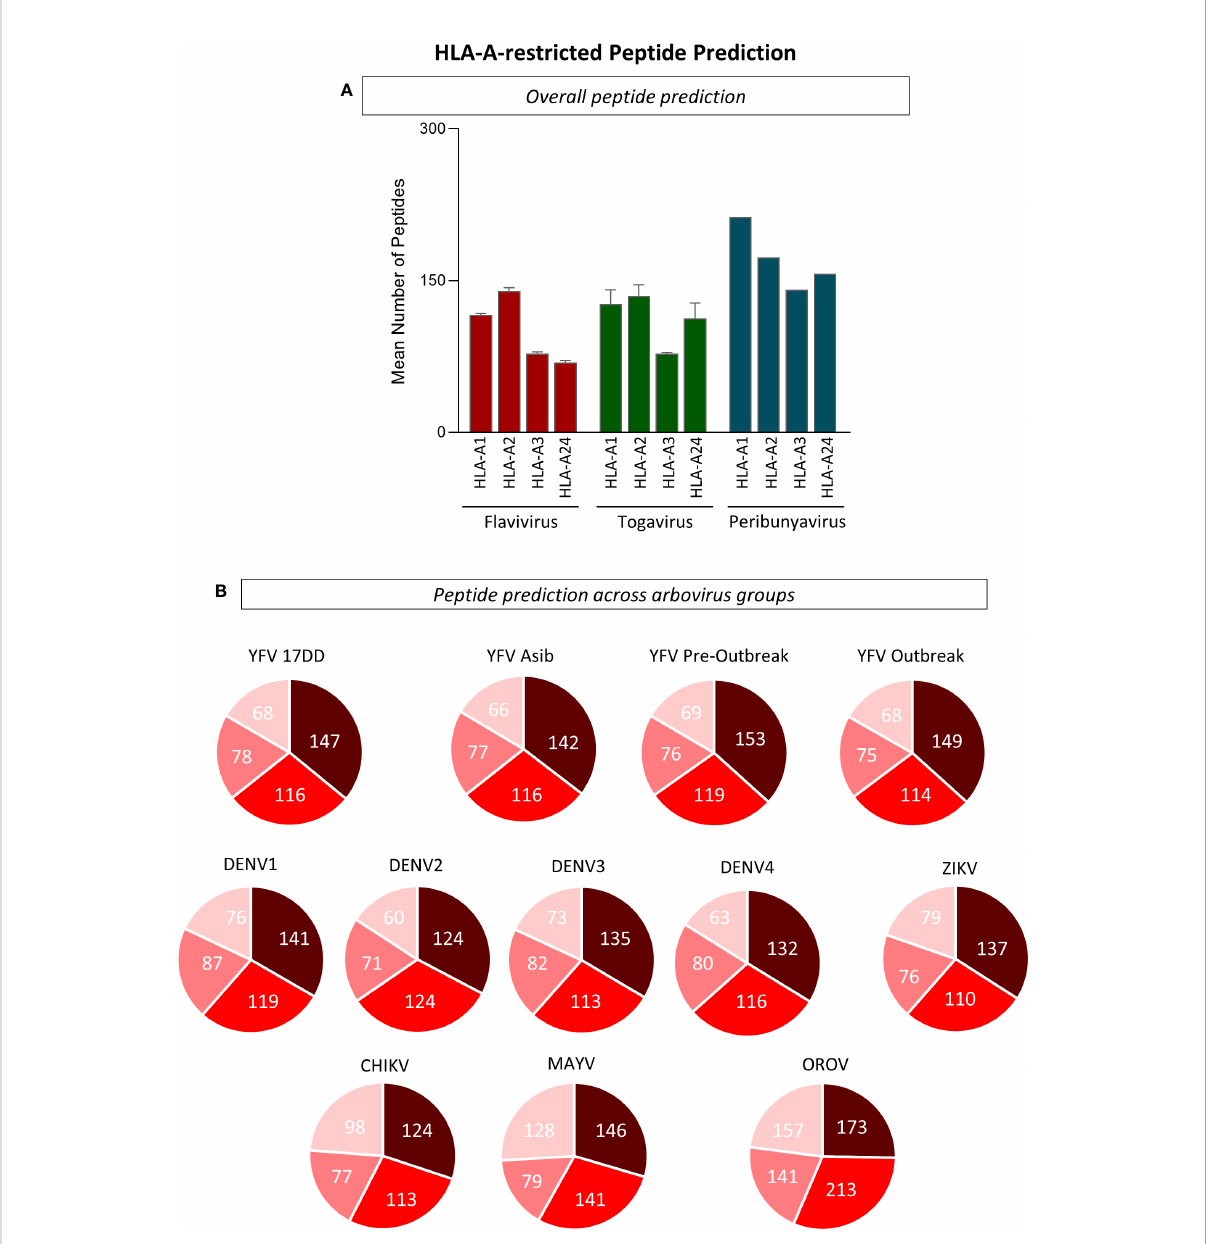
FIGURE 2 Evaluation of Peptide Restriction Regarding Human Leukocyte Antigen (HLA) Haplotype. (A) Number of restricted peptides predicted for HLA-A1, A2, A3 and A24 haplotypes using complete polyprotein sequences from Flavivirus, Togavirus and Peribunyavirus are expressed in bar graphs using mean plus standard deviation. (B) Pie charts for the number of HLA-restricted peptides for every arbovirus included in this study. Only peptides with combined prediction score ≥ 0.75 were considered in this